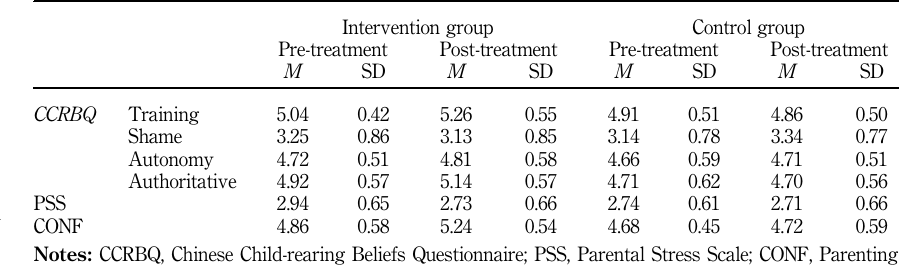
Table IV. Means and standard deviations of the parent-reported